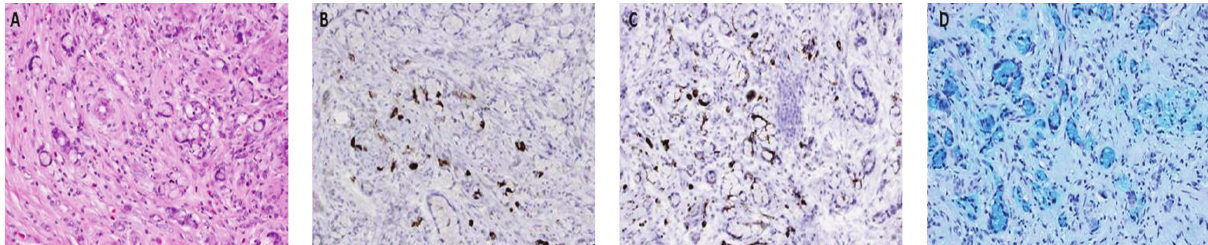
Figure 1: Histopathological examination. (A) Goblet cell carcinoid composed of cells with signet ring cells appearance with varied dilated cytoplasm due to mucin production with displacement of the nuclei to the periphery of the neuroendocrine cells location in the cytoplasm (HE, × 200); ((B) and (C)) positive staining for chromogranin A (B) and synaptophysin (C) demonstrating neuroendocrine di ff erentiation ( × 200); (D) mucin stain (Alcian Blue, ×